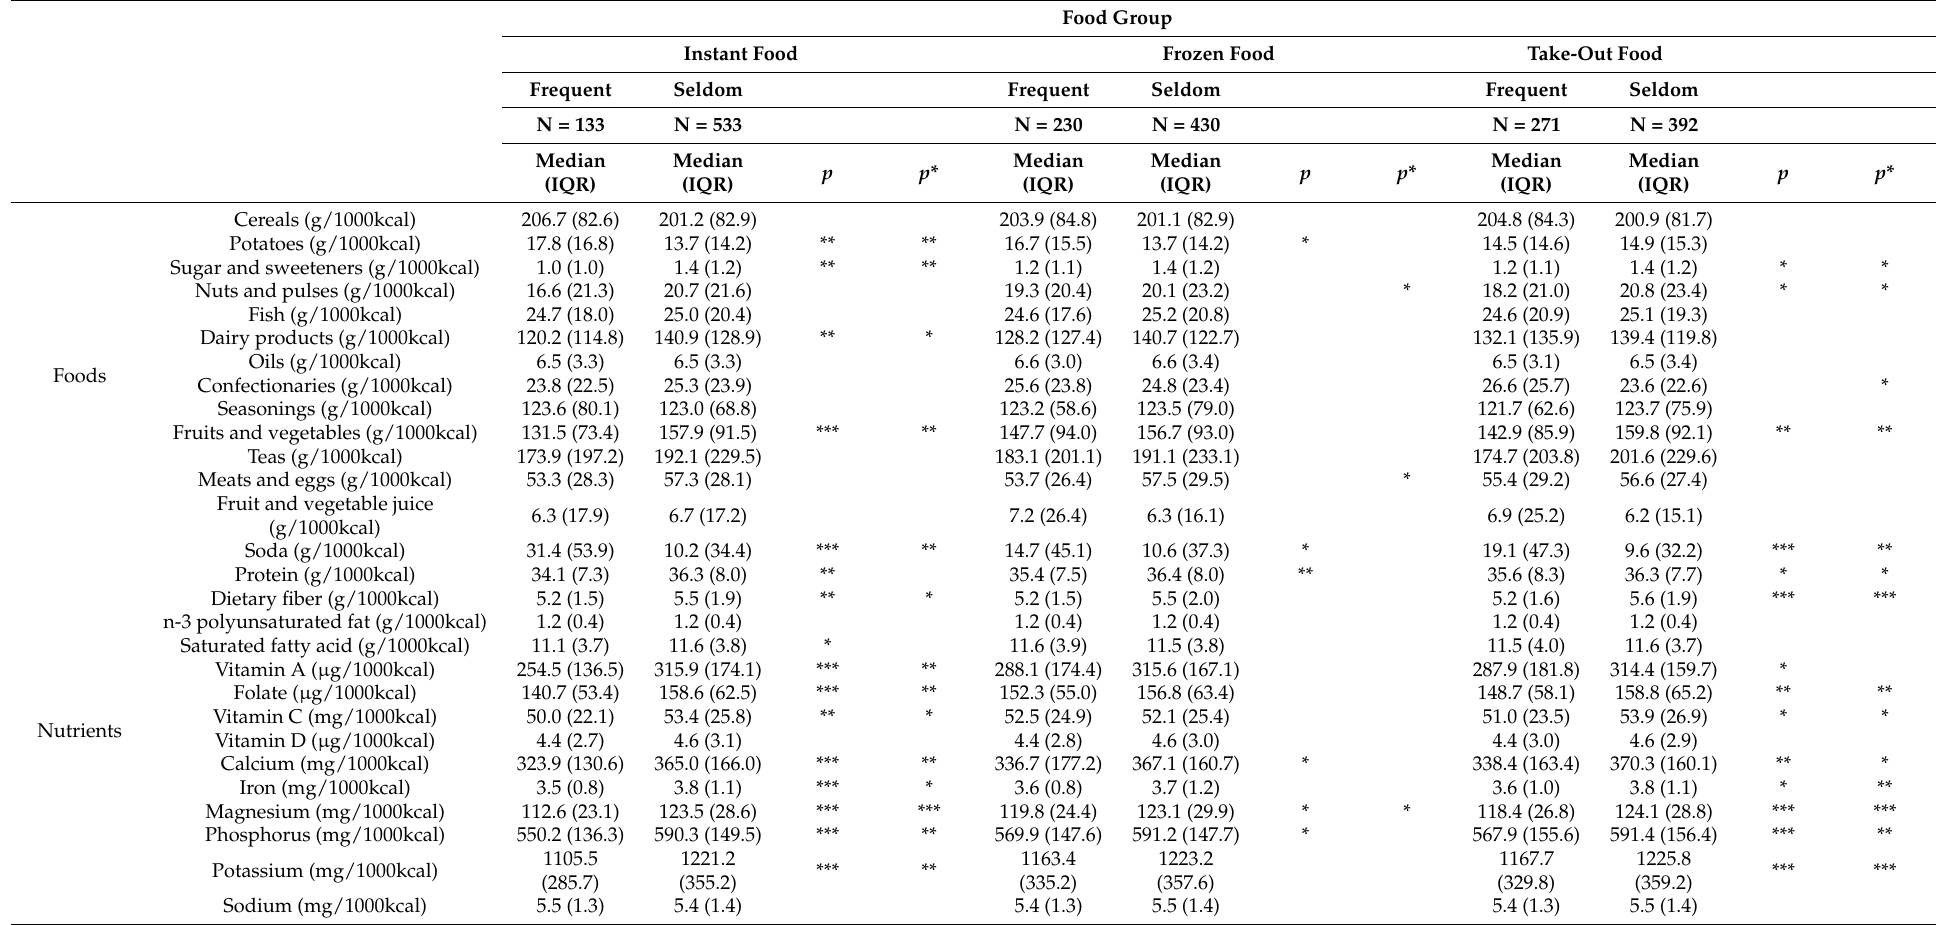
Table 3. Food and nutrient intake by frequency of convenience food